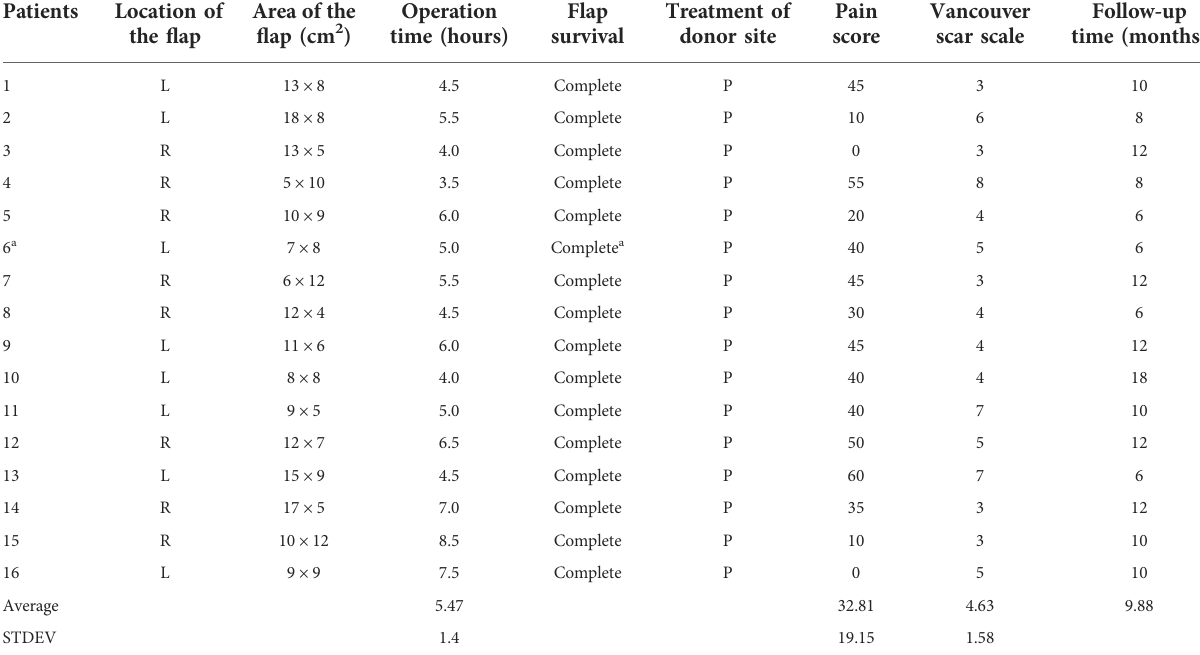
TABLE 2 Surgical